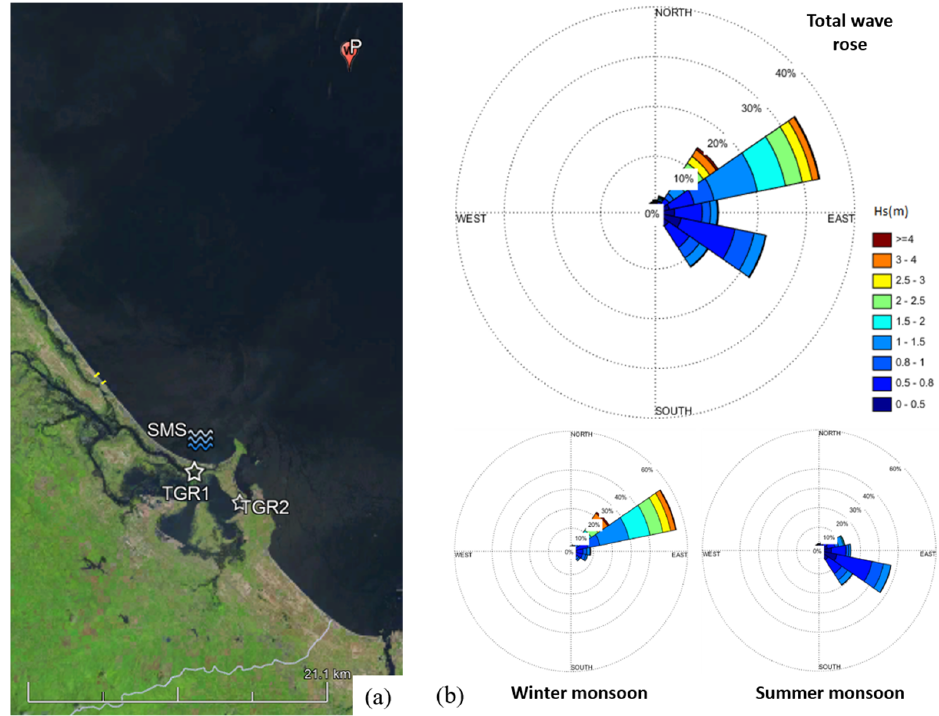
Figure 5. ( a ) Locations of water level and wave stations, ( b ) wave roses extracted at Point P .